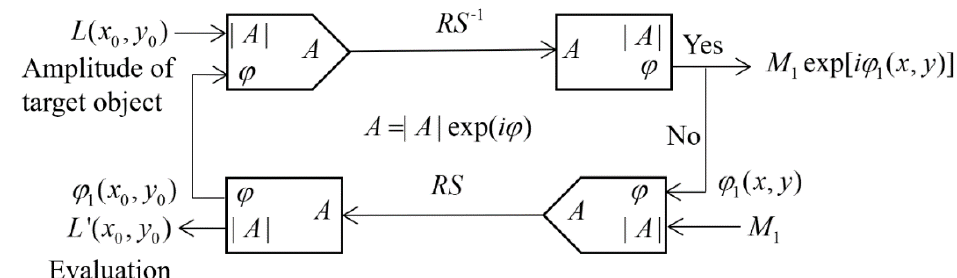
Fig. 2. Gerchberg-Saxton iterative algorithms.